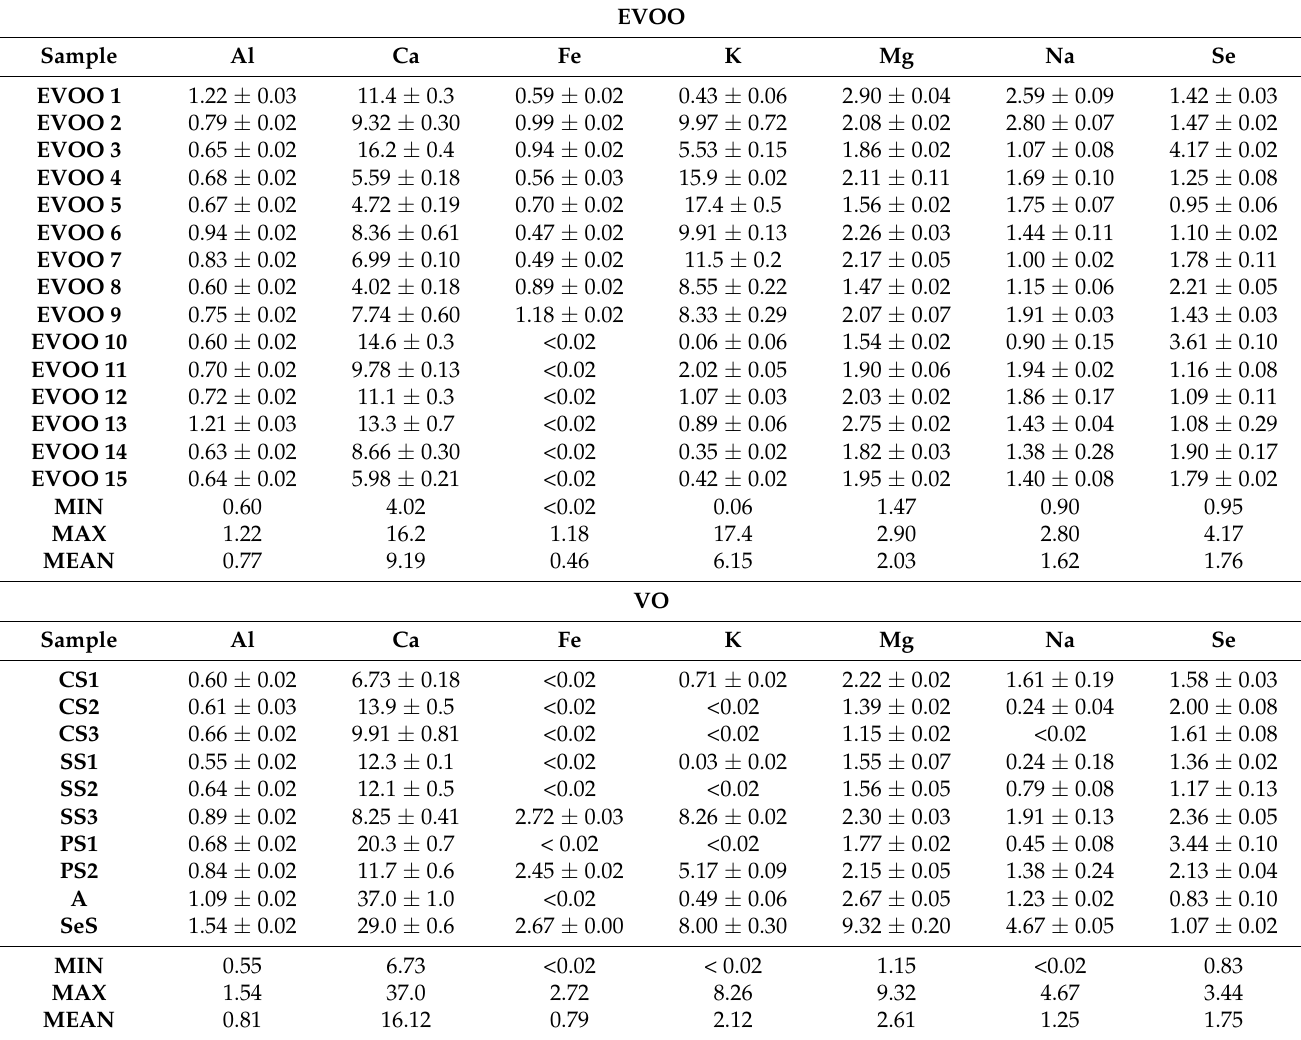
Table 4. Inorganic element content (mg kg − 1 ) in (a) EVOOs and (b)